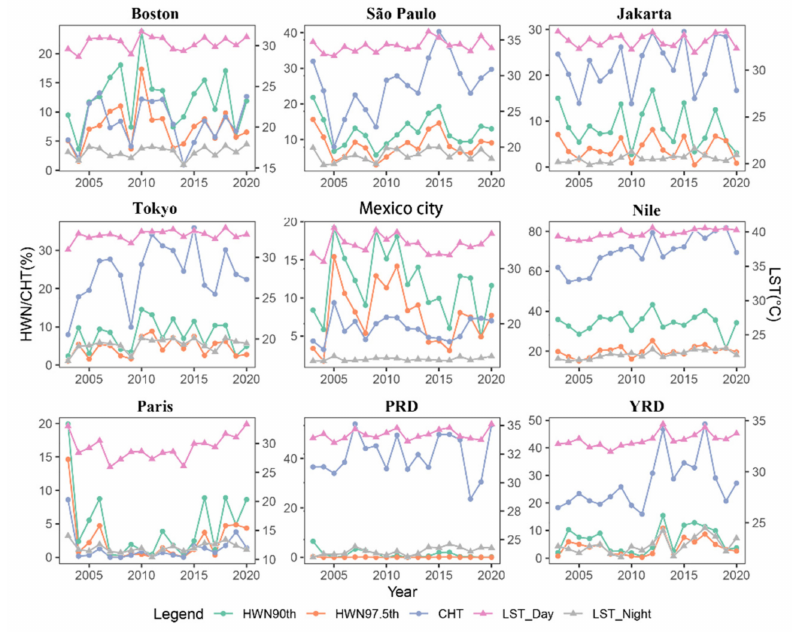
Figure 7. Time series of mean LST, CHT, and HWN in the 9